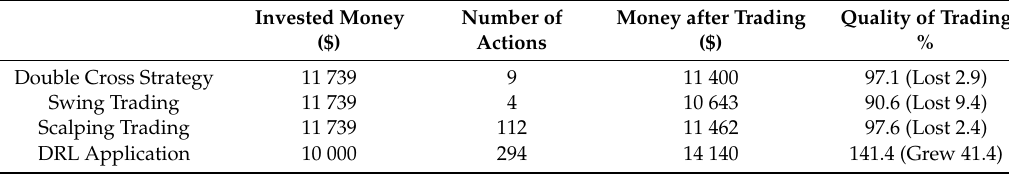
Table 6. Experiment results on Ethereum’s